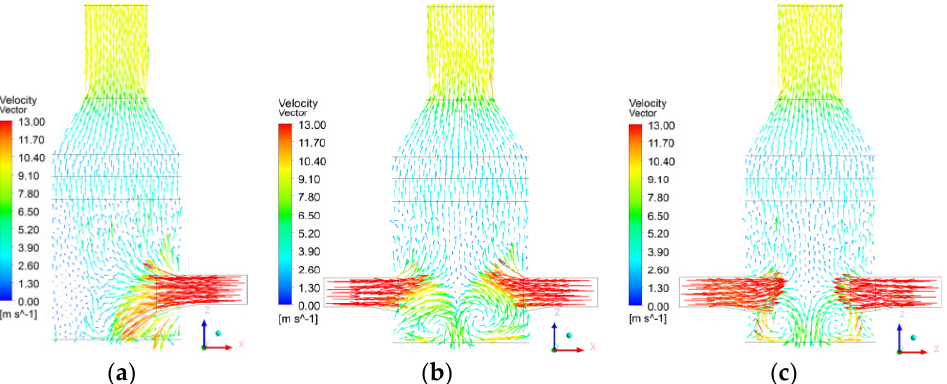
Figure 6. The gas velocity vector diagram with spray; ( a ) Single inlet; ( b ) Straight dual inlet; ( c ) Tangential dual inlet.